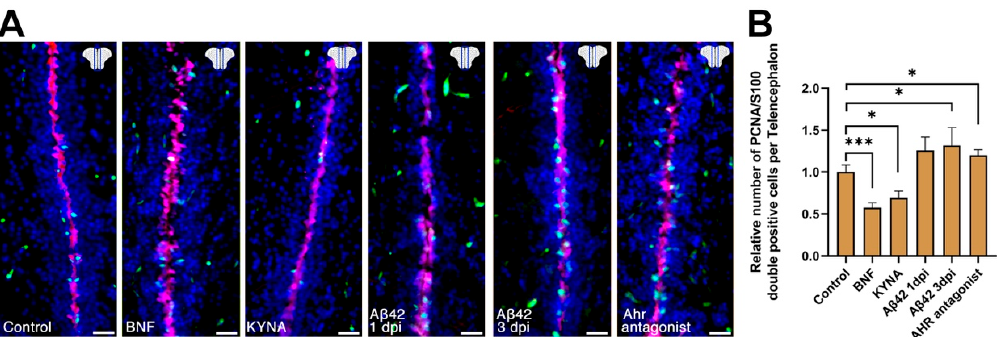
Figure 3. KYNA/Ahr2 signaling regulates neural stem cell proliferation in adult zebrafish brain. ( A ) Immunohistochemical stains for S100 β (red) and PCNA (green) in control, BNF, KYNA, A β 42 and Ahr antagonist injected brains. ( B ) Quantification of relative numbers of proliferating glial cells in conditions in A. Scale bars equal 50 μ m. Statistical calculations and values are provided in Table S1.